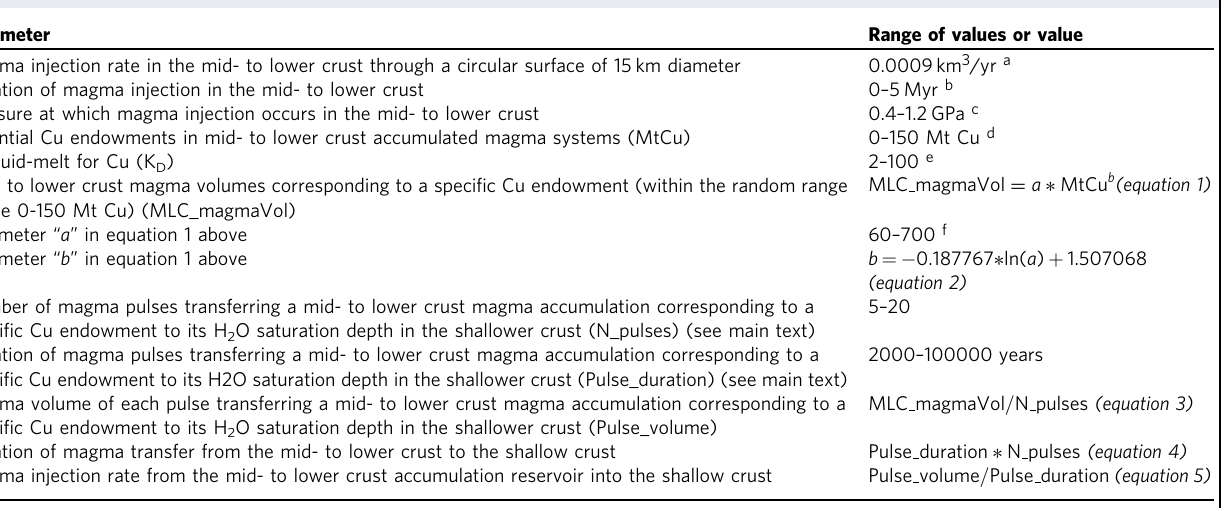
Table 1 Constraints on the parameters used in the Monte Carlo modelling of magma injection rates.